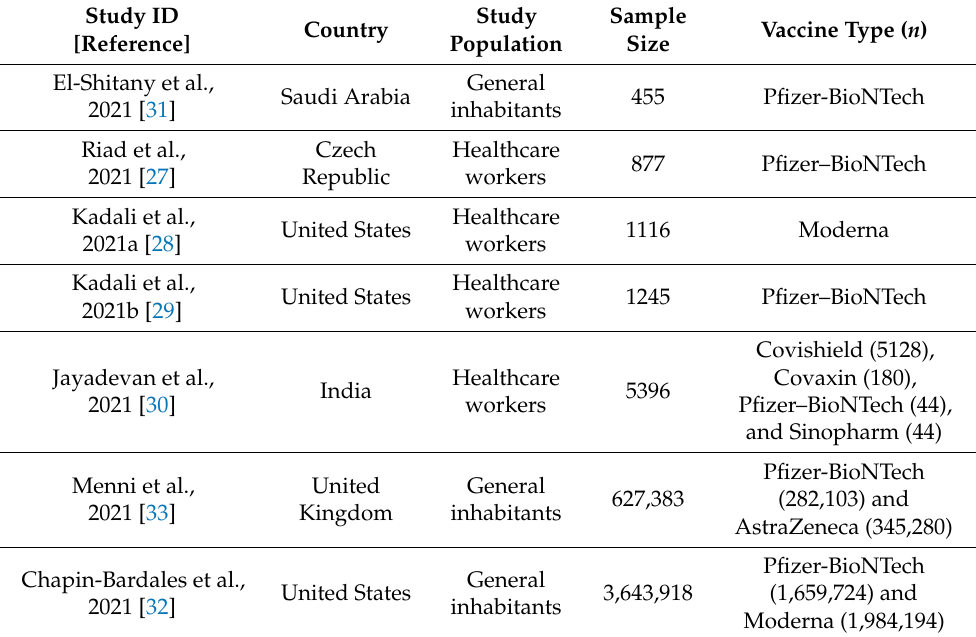
Table 9. List of studies that assessed the side effects that occurred following COVID-19